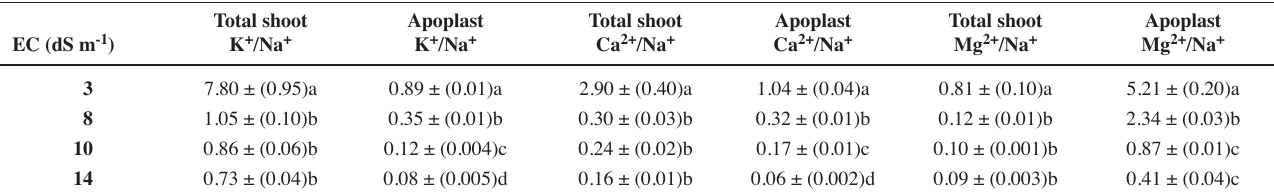
Tab. 2: Influence of different EC levels on the K + /Na + , Ca 2+ /Na + and Mg 2+ /Na + ratios in total shoot and apoplast of maize plants. Different letters indicate significant differences between the treatments at P < 0.05 (n ≥ 3),